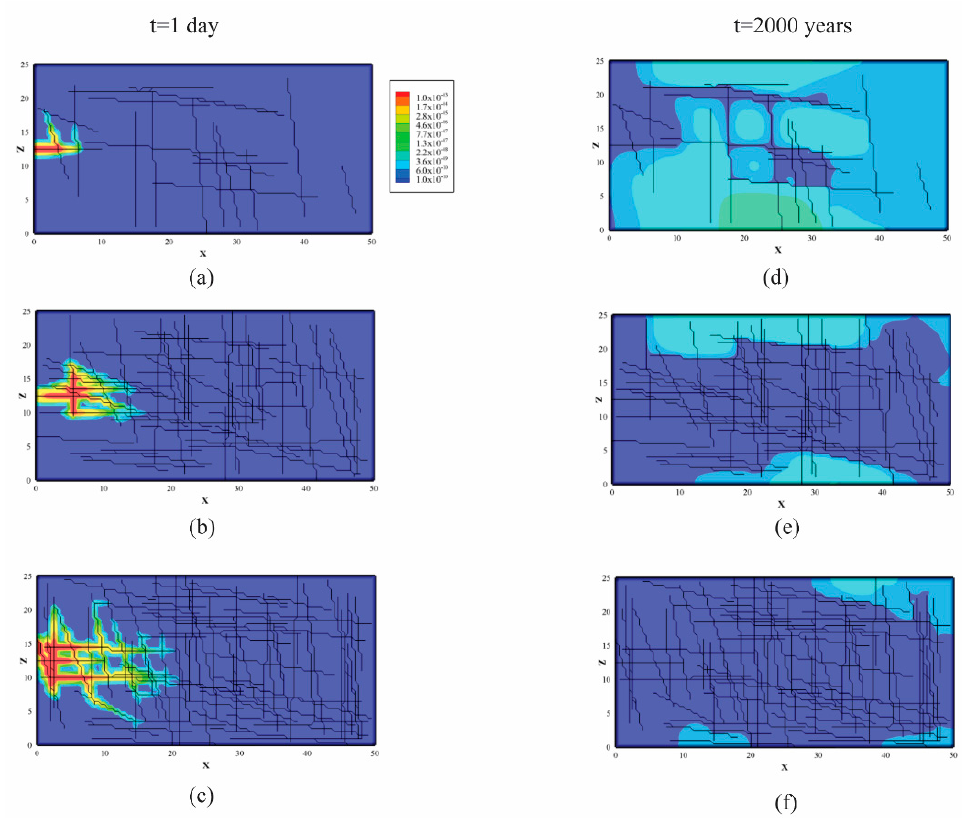
Figure 4. One realization of plume snapshots for the first time step ( t = 1 day) for the three different fracture densities: ( a ) the DFNs with 20 fractures; ( b ) 60 fractures; and ( c ) 80 fractures. The 13th time step ( t = 2000 years) for the three different fracture densities: ( d ) 20 fractures; ( e ) 60 fractures; and ( f ) 80 fractures.